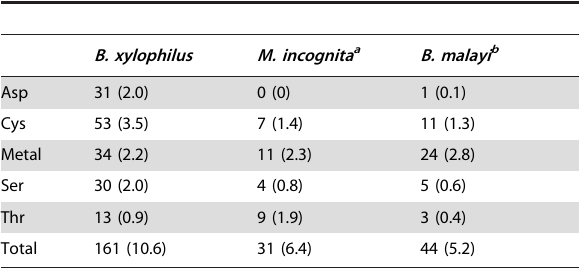
Table 1. Summary of secreted peptidases in Bursaphelenchus xylophilus and other